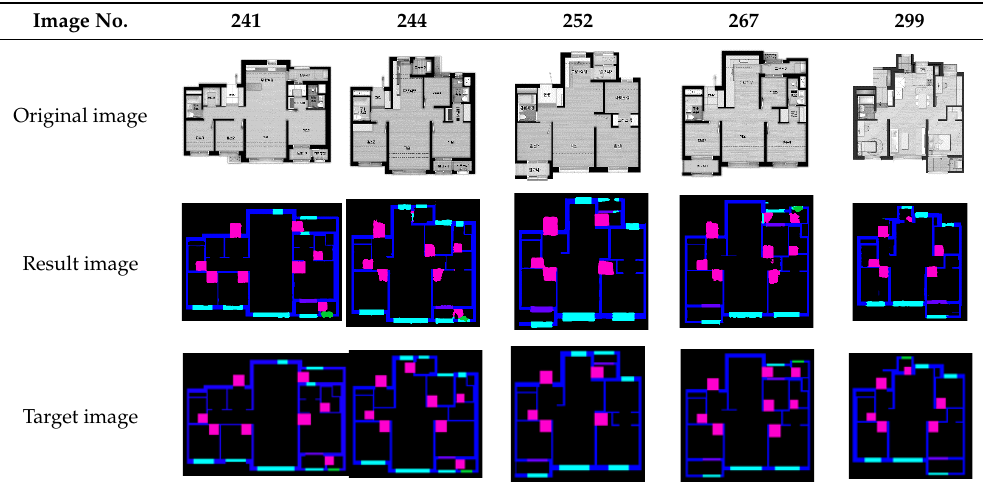
Table 2. Original image, result image, target image of experiment1.